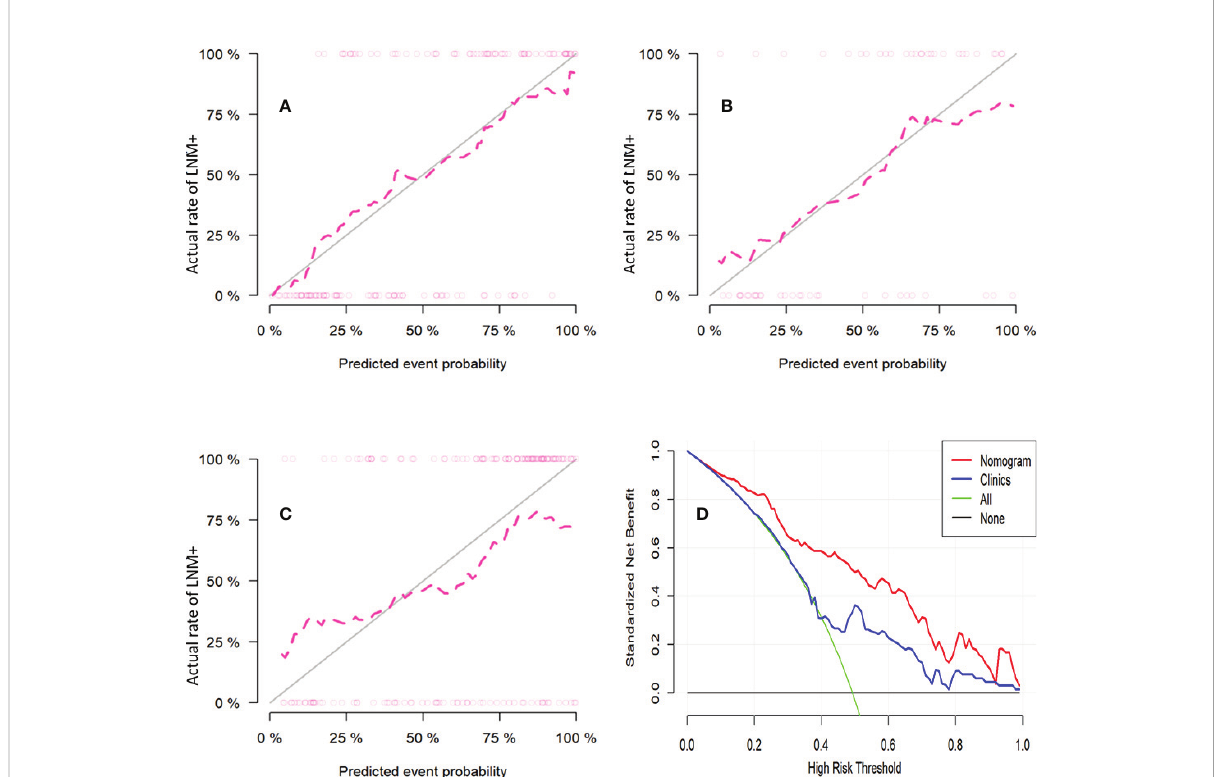
FIGURE 5 The calibration curves for the nomogram in training cohort (A) , internal validation cohort (B) and external validation cohort (C) . The diagonal gray line represents a perfect prediction by an ideal model. The pink dotted line represents the performance of the nomogram, of which a closer fi t to the diagonal gray line represents a better prediction (Hosmer-Lemeshow test all p-values >0.05). Decision curve analysis of nomogram to investigate the clinical usefulness in predicting lymph node metastasis (D) . It indicates the nomogram model obtains more bene fi t than “ treat all ” , “ treat none ” , and the clinical model when the threshold probability is >10% in training cohort.